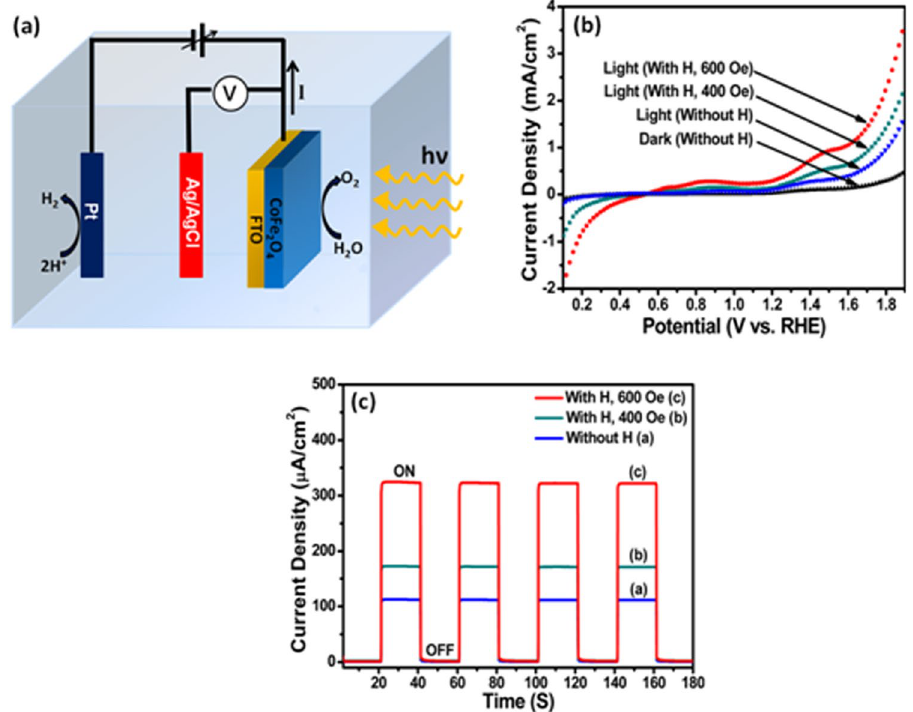
Figure 2. ( a ) Schematic representation of three electrode cell assembly for photoelectrochemical measurements, ( b ) current-potential curves of CoFe 2 O 4 photoanode measured with and without magnetic field (under 100 mW/ cm 2 UV-vis illumination), ( c ) chronoamperometry results of CoFe 2 O 4 nanostructure film in the presence of magnetic fields of different